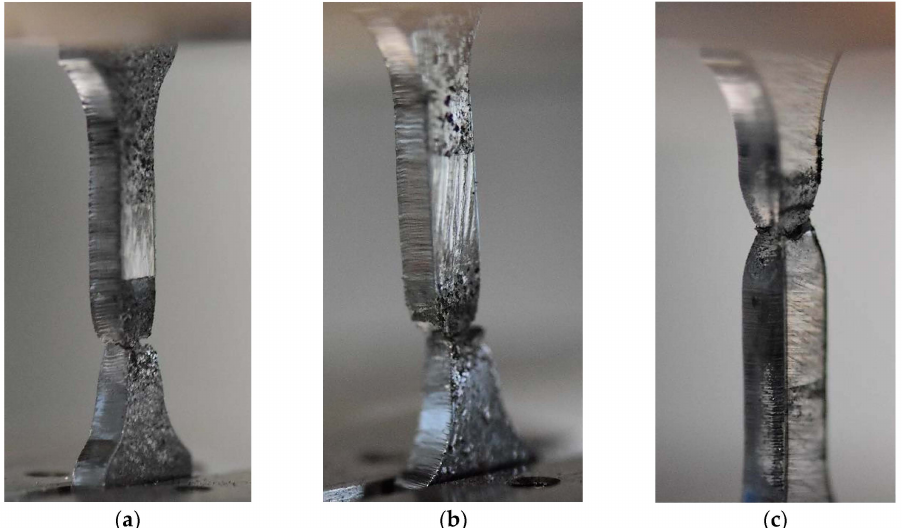
Figure 10. Fracture zones of tensile specimens with joints manufactured at the welding wires: ( a ) Union NiMoCr, ( b ) EDFK 1000, ( c ) Union